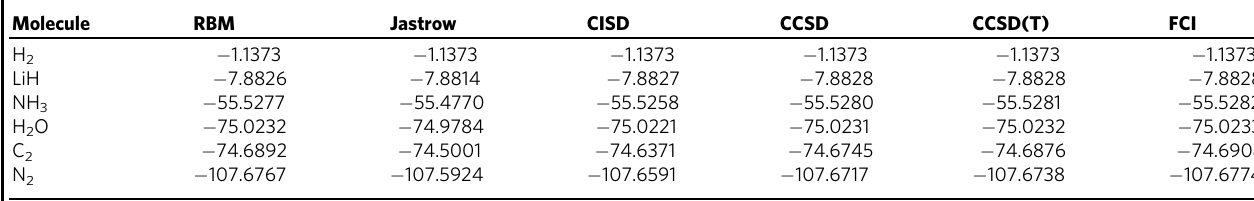
Table 1 Equilibrium energies (in Hartree) as obtained by different methods. Molecule